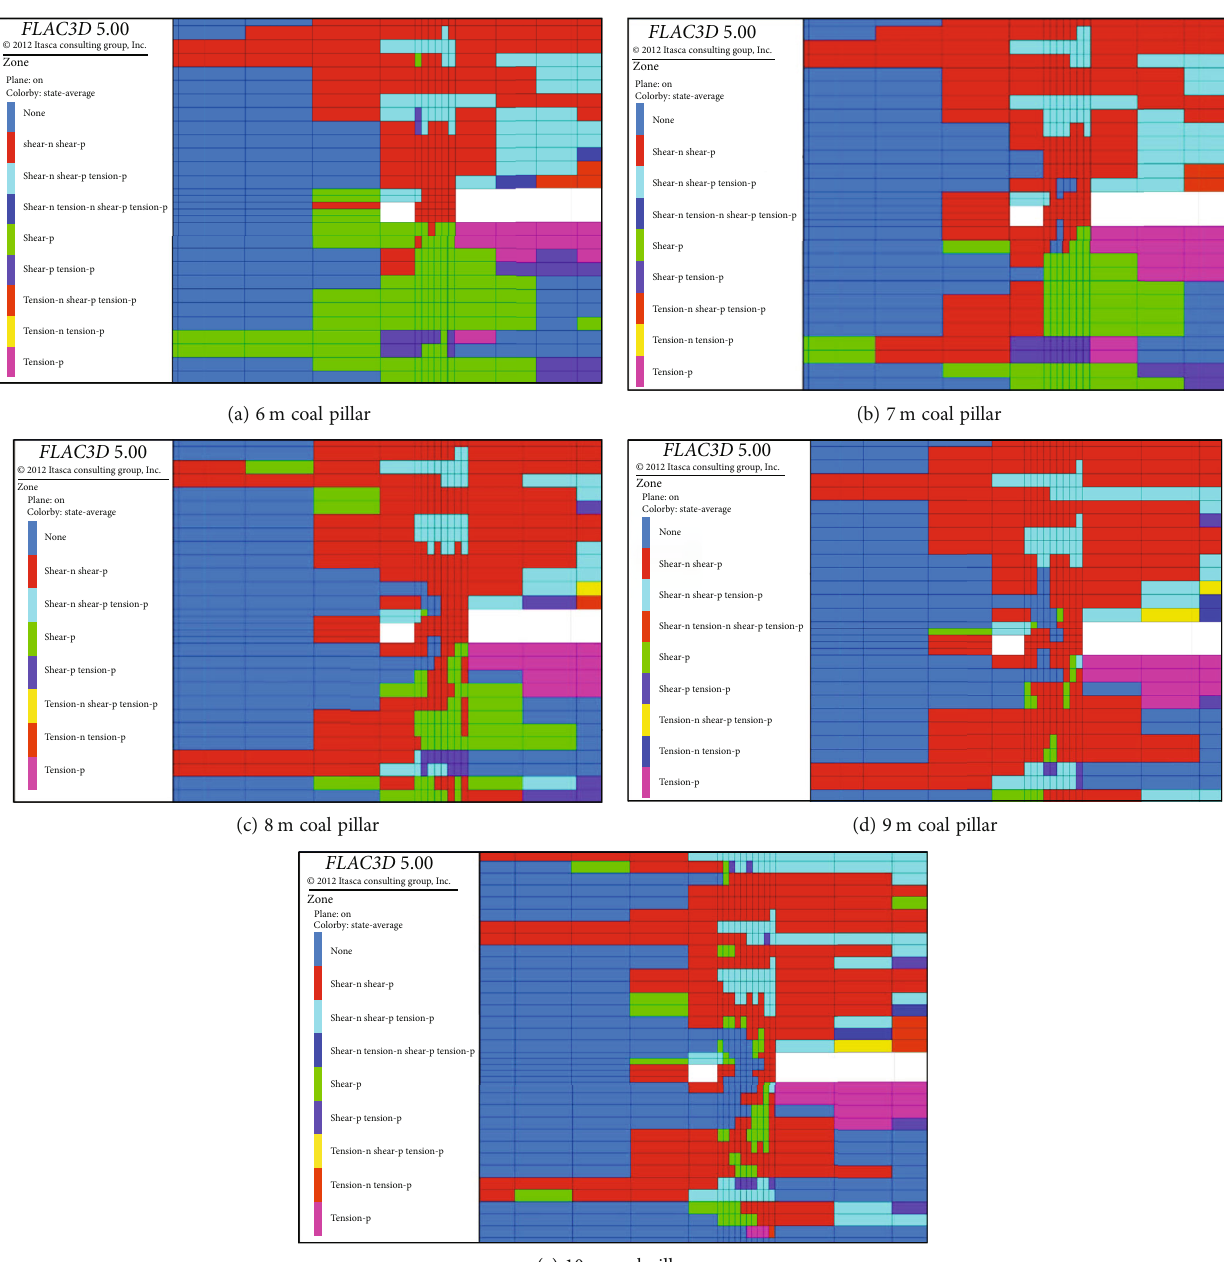
Figure 8: Plastic zone distribution in coal pillars with di ff erent widths and surrounding rock of roadway along goaf when the workface was advanced 200